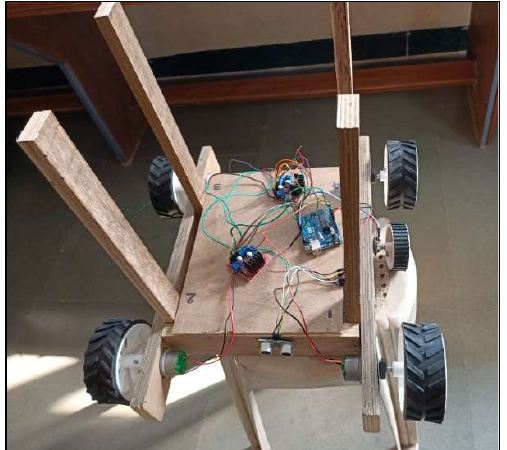
Fig. 17. Autonomous Travel